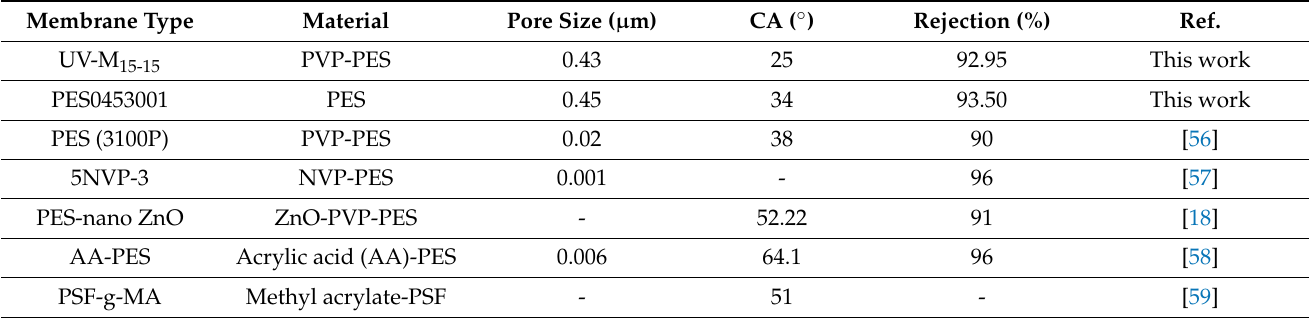
Table 5. Features of the prepared PES membranes in this work and from literature according to hydrophilization UV